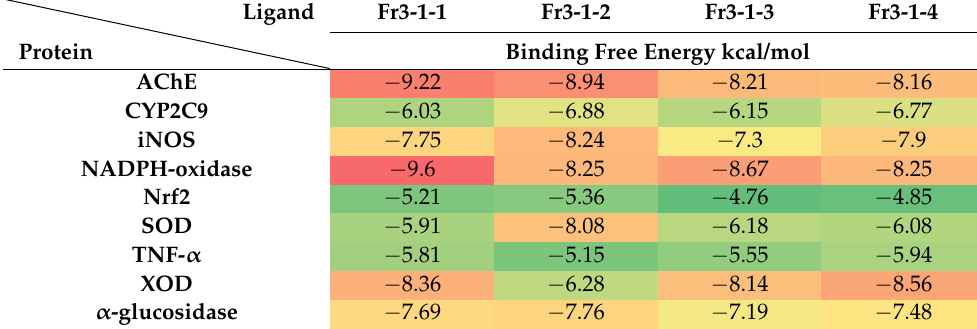
Table 2. Heat map of recorded docking scores of these ligands and protein targets.